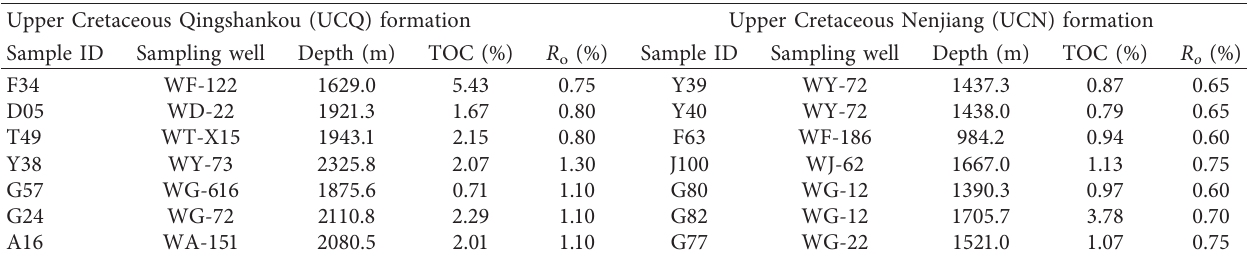
Table 1: Basic information of collected oil shale samples.